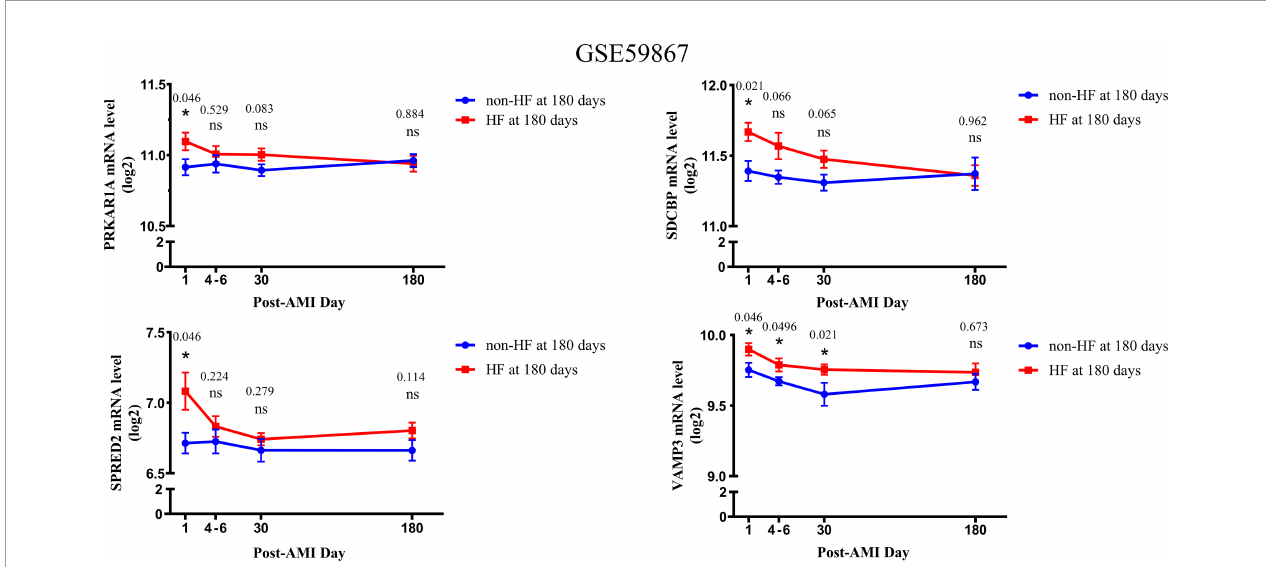
FIGURE 4 | The changes in expression levels of key bio-correlated genes over time, following AMI in the GSE59867 dataset. The changes in gene expression levels were observed in the HF and non-HF groups at different time points after AMI (1d: n = 9 vs. 8, 4 – 6 days: n = 9 vs. 6, 30 days: n = 8 vs. 8, 180 days: n = 9 vs. 8). The P-value was shown above the asterisk (*). *P < 0.05; n.s., no signi fi cance vs. non-HF group. Data are presented as mean ± SEM. AMI, acute myocardial infarction; HF, heart failure; SEM, standard error of mean.